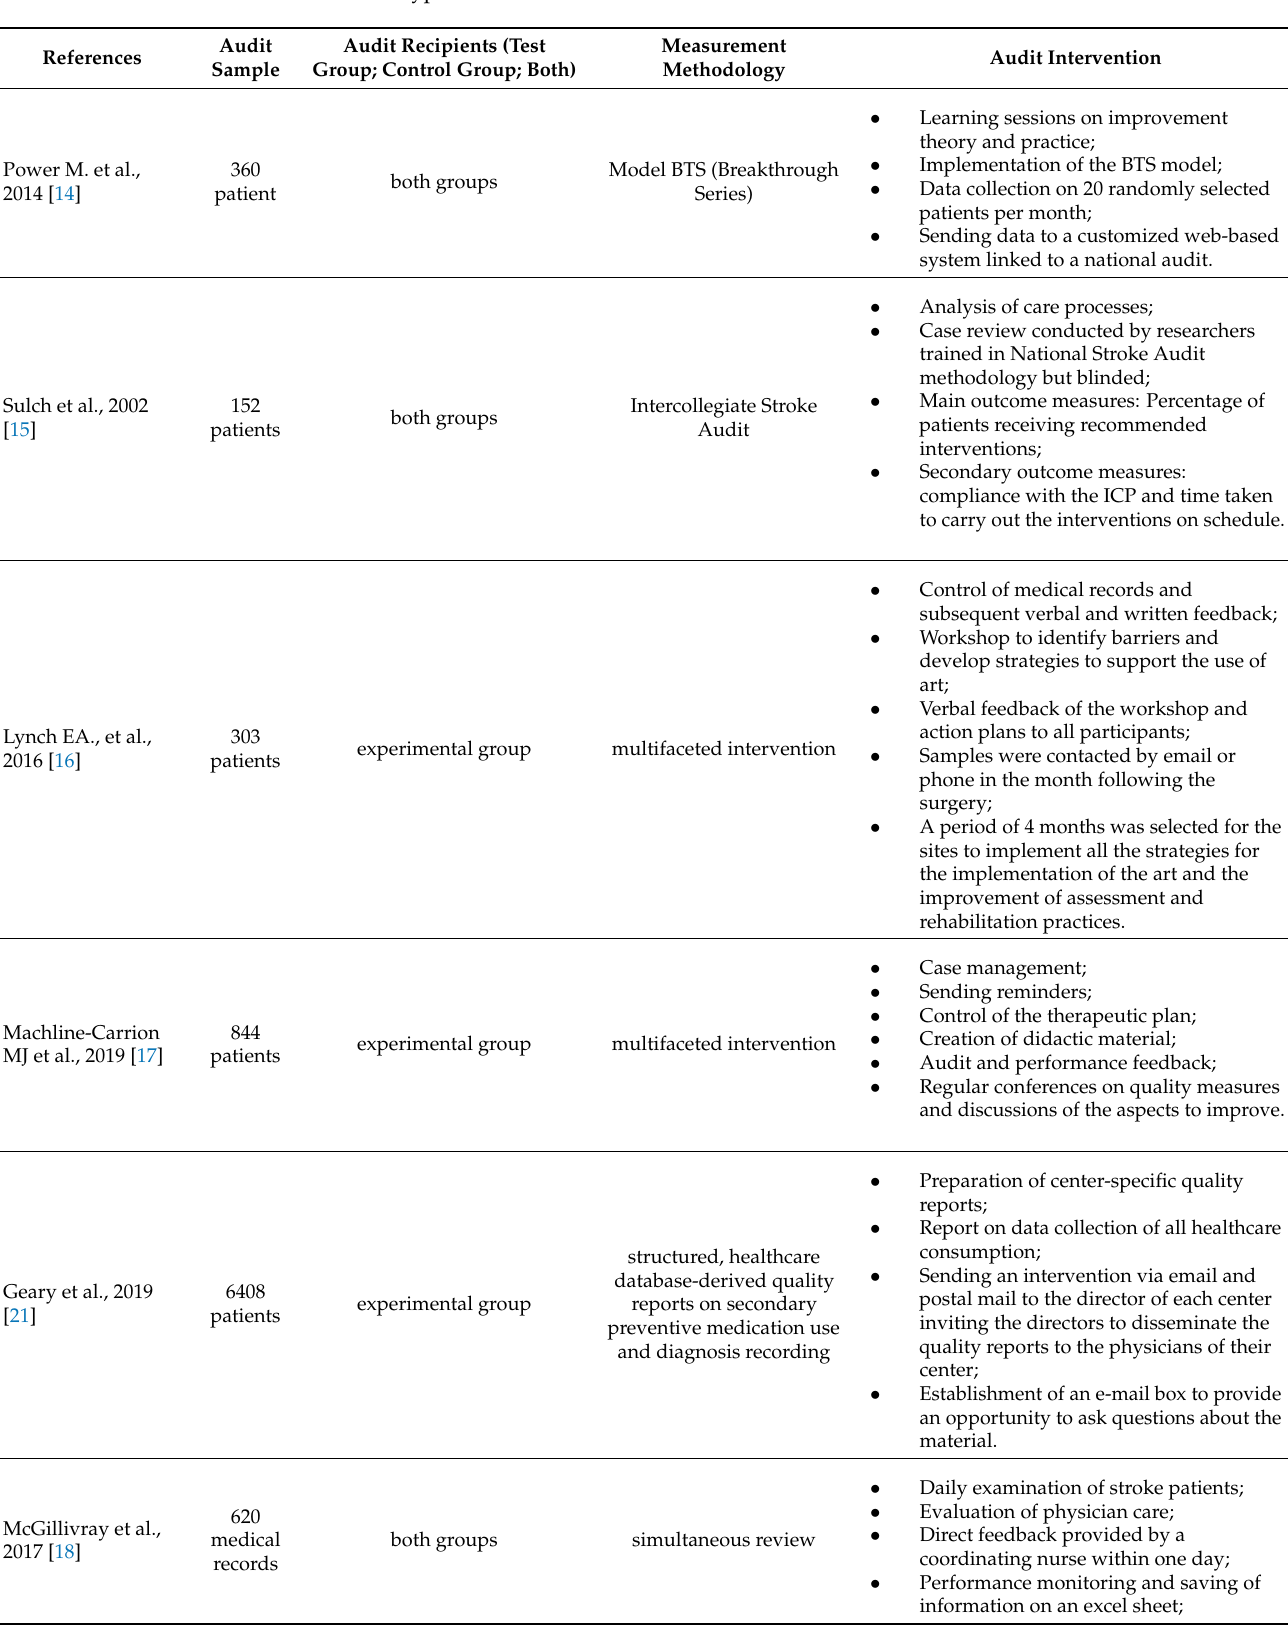
Table 2. Type of